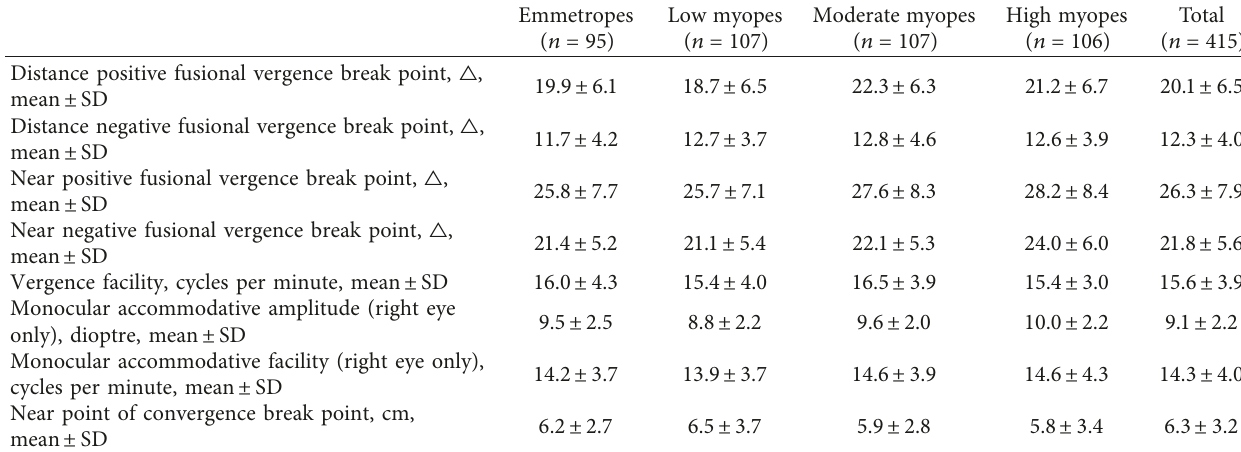
Table 4: Mean values of various binocular vision and accommodation test results by refractive error